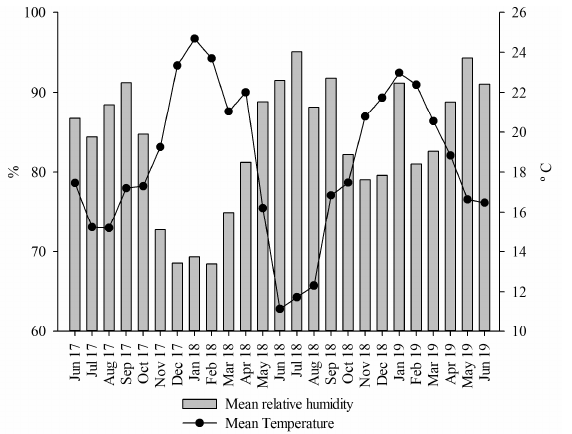
Figure 2. Evolution of mean relative humidity (%) (left Y axis) and mean temperature (°C) (right Y axis) for the study period.